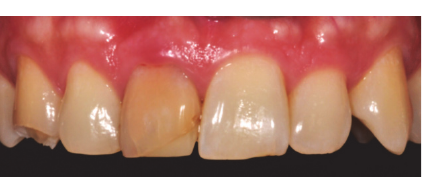
Figure 1: PES/WES started score: